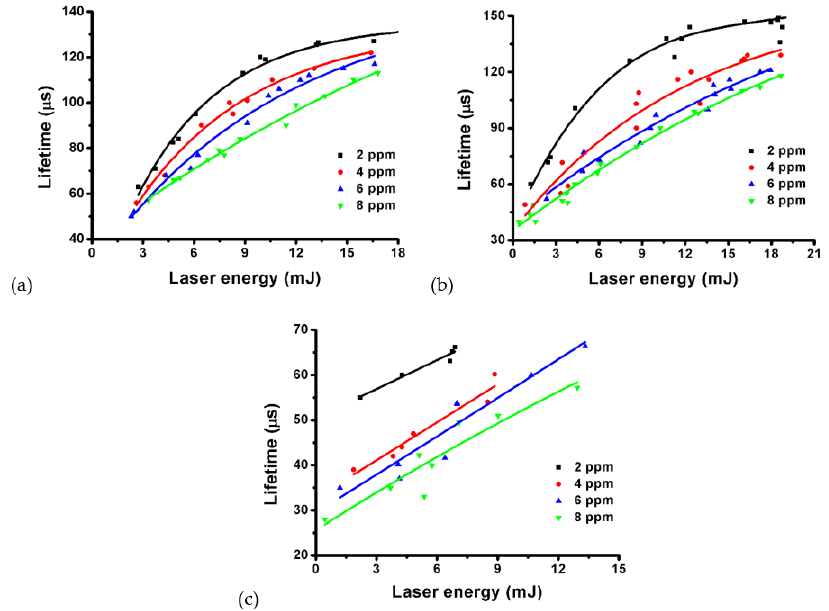
Figure 9. Lifetime of single microbubble versus pulsed energy of ( a ) 980 nm laser and ( b ) 700 nm laser in GNR colloids (SPR: 718 nm) of different concentrations (2, 4, 6 and 8 ppm). ( c ) The results of 980 nm laser in GNR colloids (SPR: 966 nm) of different